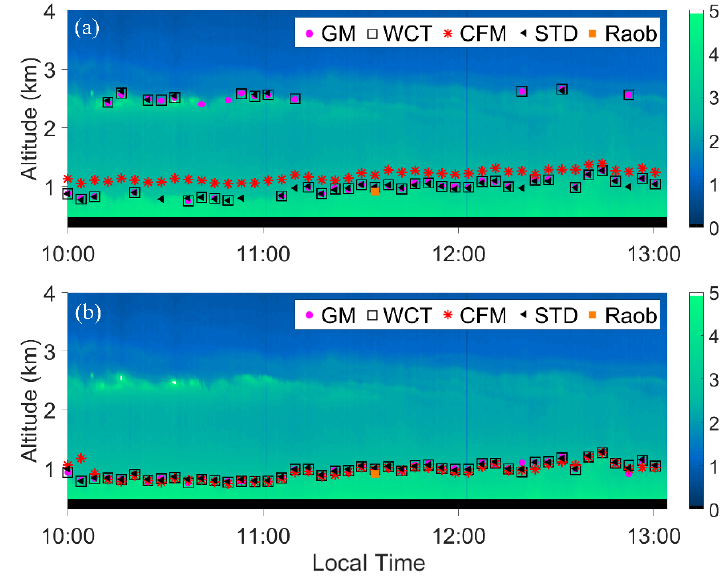
Figure 10. Same as Figure 9, except for the misty elevated aerosols 19 August 2017, 10:00–13:00 LT. In contrast, on 25 August 2017 between 11:00 and 14:00 LT, clouds formed near the top of the